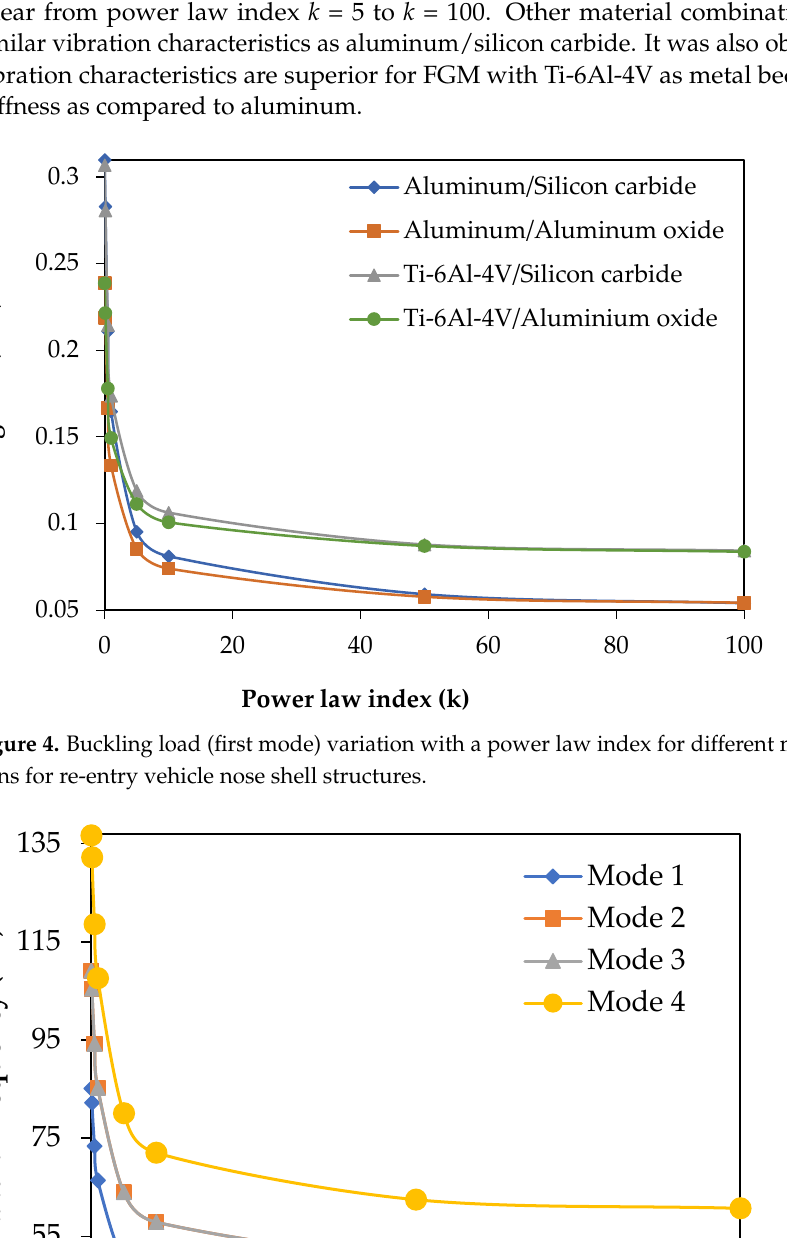
Figure 4. Buckling load (first mode) variation with a power law index for different material com- binations for re-entry vehicle nose shell structures.